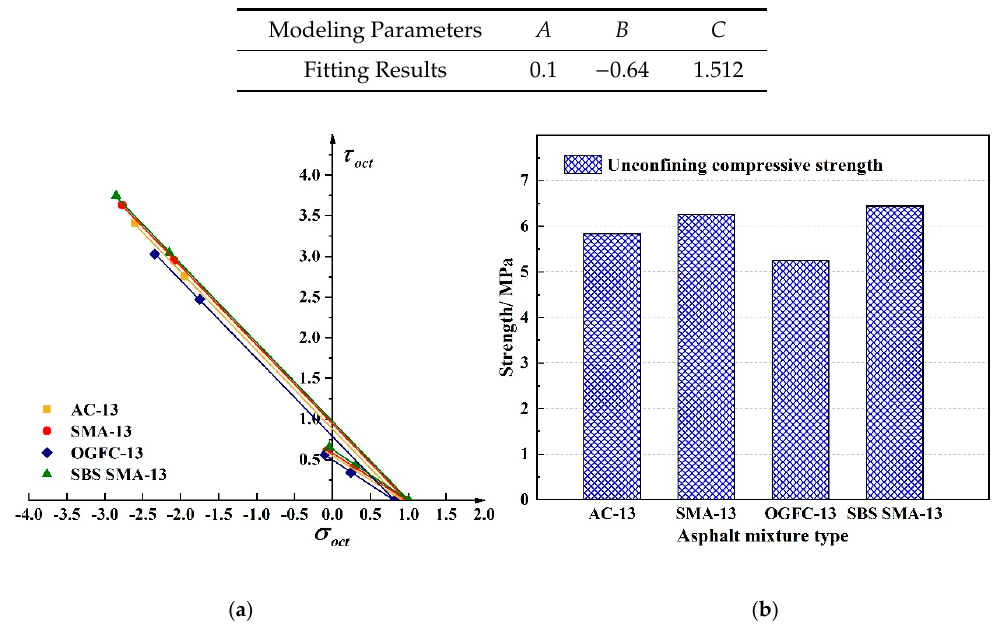
Table 5. Fitting parameters of linear model under di ff erent gradation.